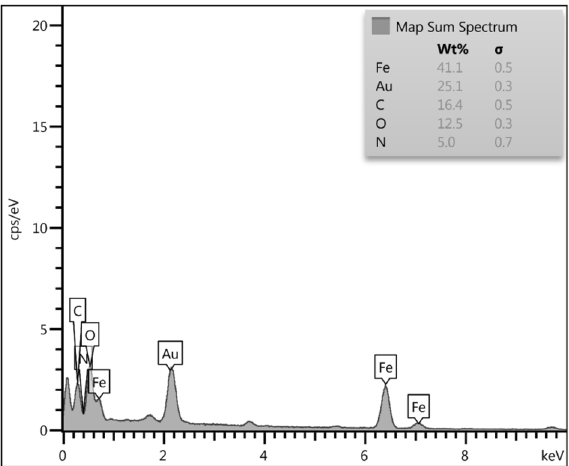
Figure 3. EDX pattern of GO/Fe 3 O 4 @PDA/Au